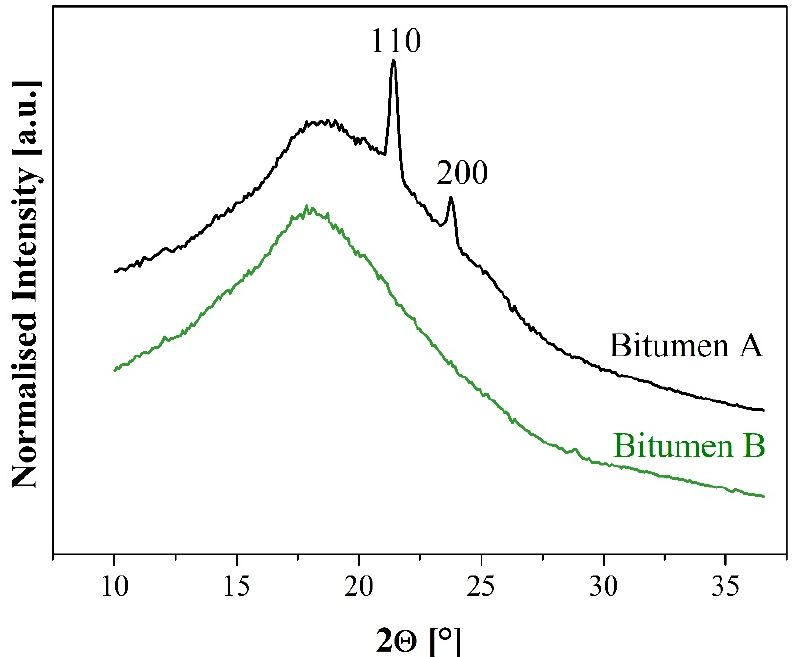
Figure 3. Normalised synchrotron WAXD patterns of bitumen A and B at room temperature (25 °C) where data are shifted along the intensity axis to avoid overlap and reflections are labelled with their Miller indices.